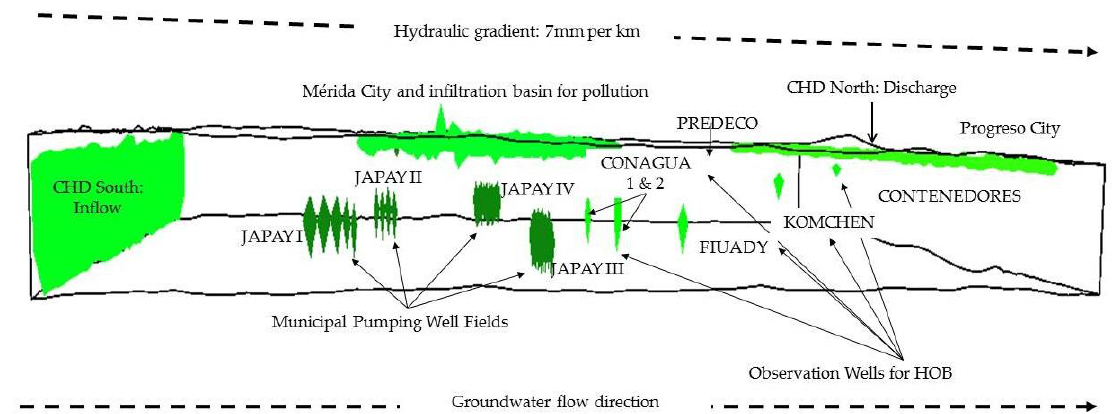
Figure 4. A 3D presentation of the study site, including all active objects and packages used to run the groundwater numerical solution and the transport model.